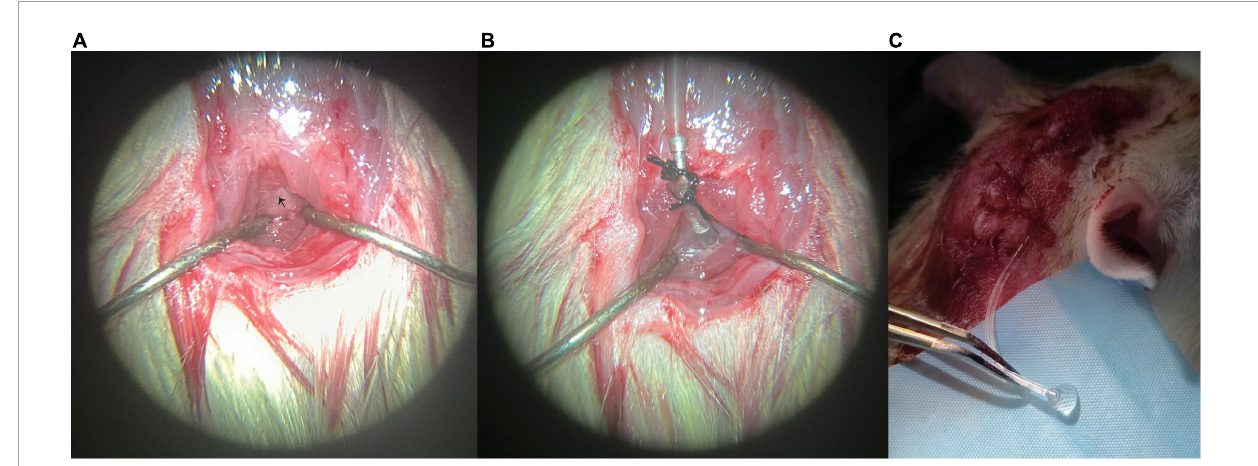
FIGURE2 Representative photos of the modified cannulation implantation: (A) fascia and superficial muscles were bluntly separated at the midline, and the atlantooccipital membrane was exposed, (B) cannulation was implanted into the cisterna magna, and (C) clear cerebrospinal fluid (CSF) can be seen flowing out of the external segment (PE tube). CSF, cerebrospinal fluid. Black arrow marks the atlantooccipital membrane.